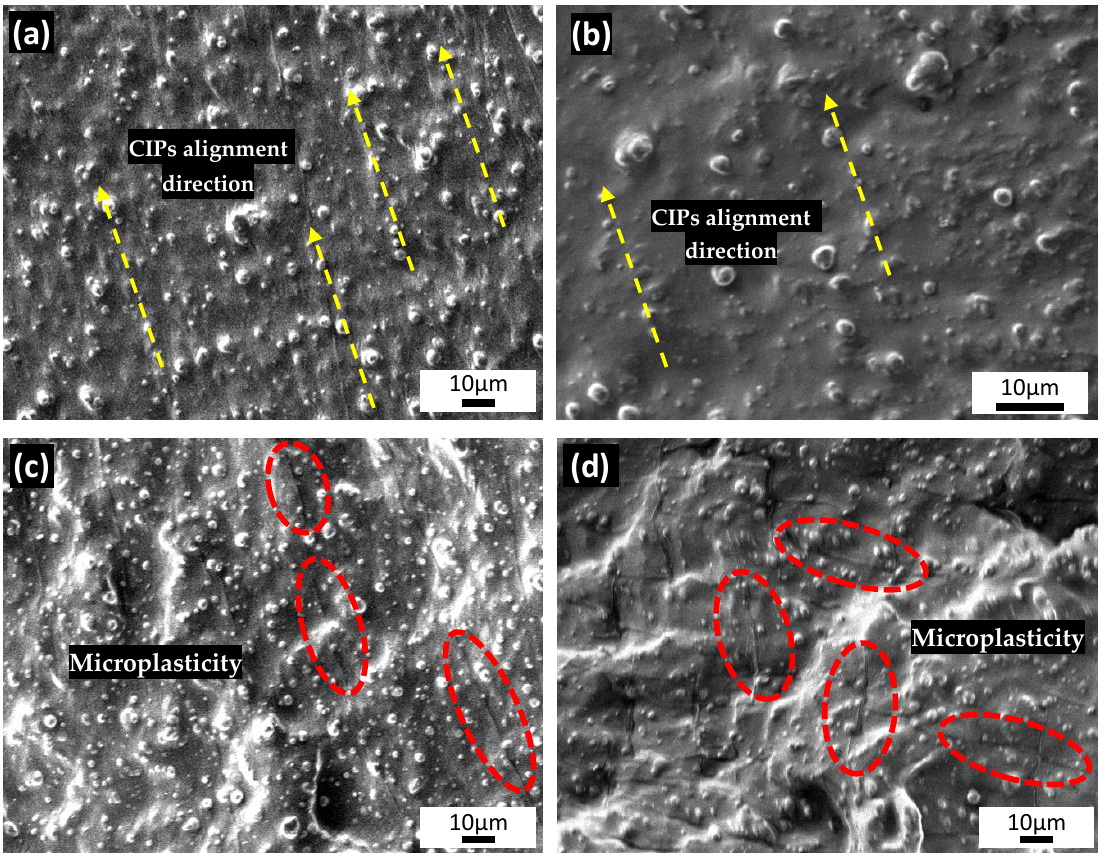
Figure 5. FESEM images for anisotropic MRE with particle alignment of ( a ) 20 vol.%, and ( b ) 10 vol.%, and microplasticity formation on ( c ) 20 vol.% and ( d ) 10 vol.% CIPs.